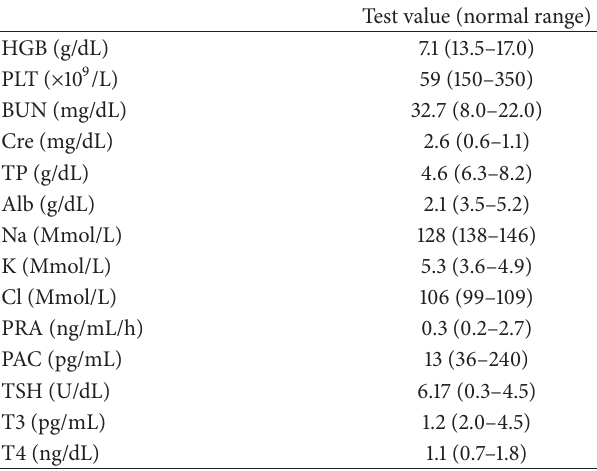
Table 2: Preoperative laboratory test